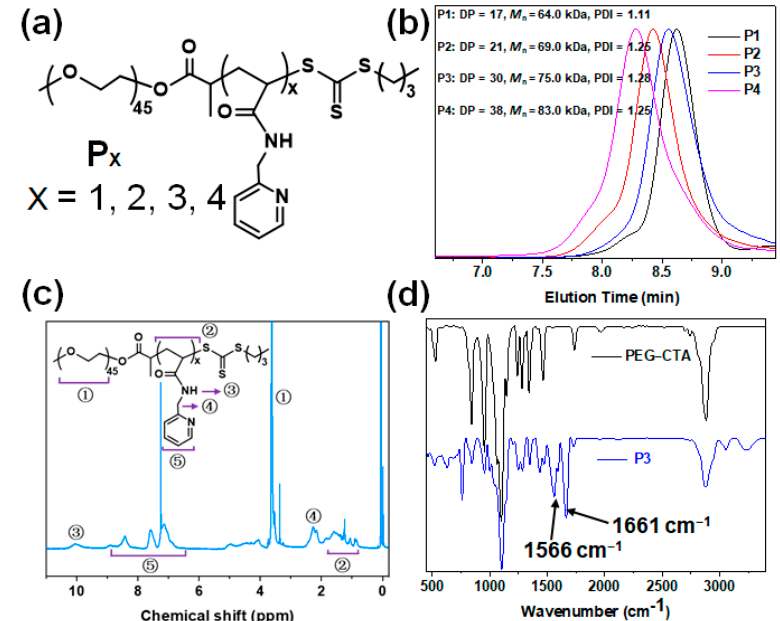
Figure 1. ( a ) Chemical structures of the block-copolymers P1–P4. ( b ) GPC curves of P1–P4 after the RAFT polymerization of MPA in ethanol. ( c ) Typical 1 H NMR spectrum of P3 in CDCl 3 at 25 °C. ( d ) Typical FT–IR spectra of P3 (blue line) and PEG–CTA (black line).